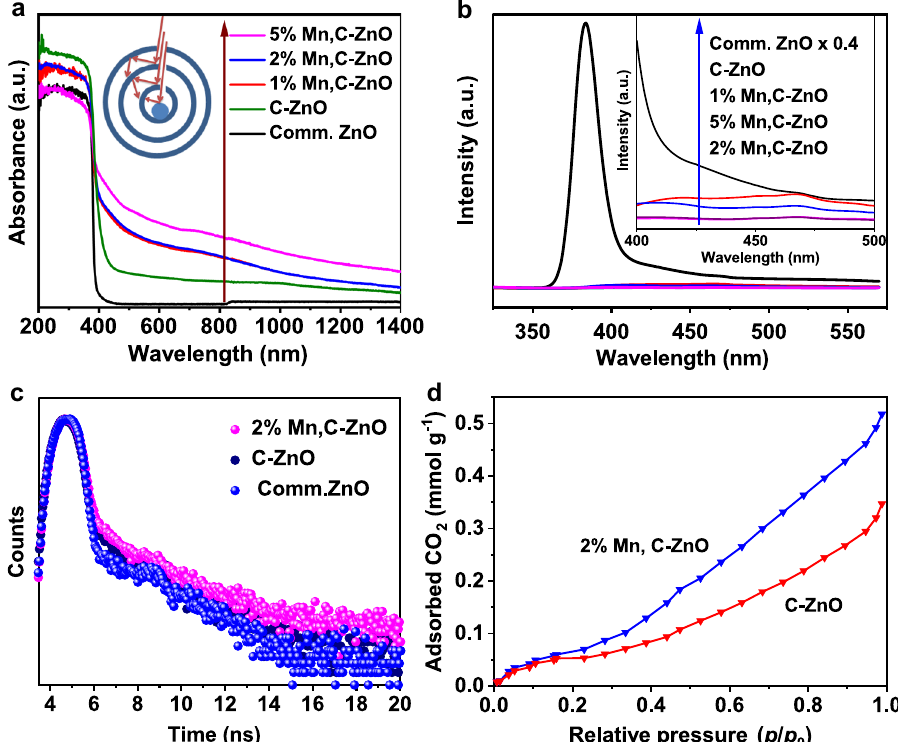
Fig. 5 Optical and adsorption properties studied catalysts. a UV – vis light absorption of the prepared photocatalysts and the inset represents the multiple re fl ection effect of the incident light inside the hollow cavities. b PL spectra of photocatalysts at excitation wavelength of 380 nm. c TRPL spectra of the samples. d CO 2 adsorption isotherm of C-ZnO CTSHSs and 2% Mn, C-ZnO-CTSHS